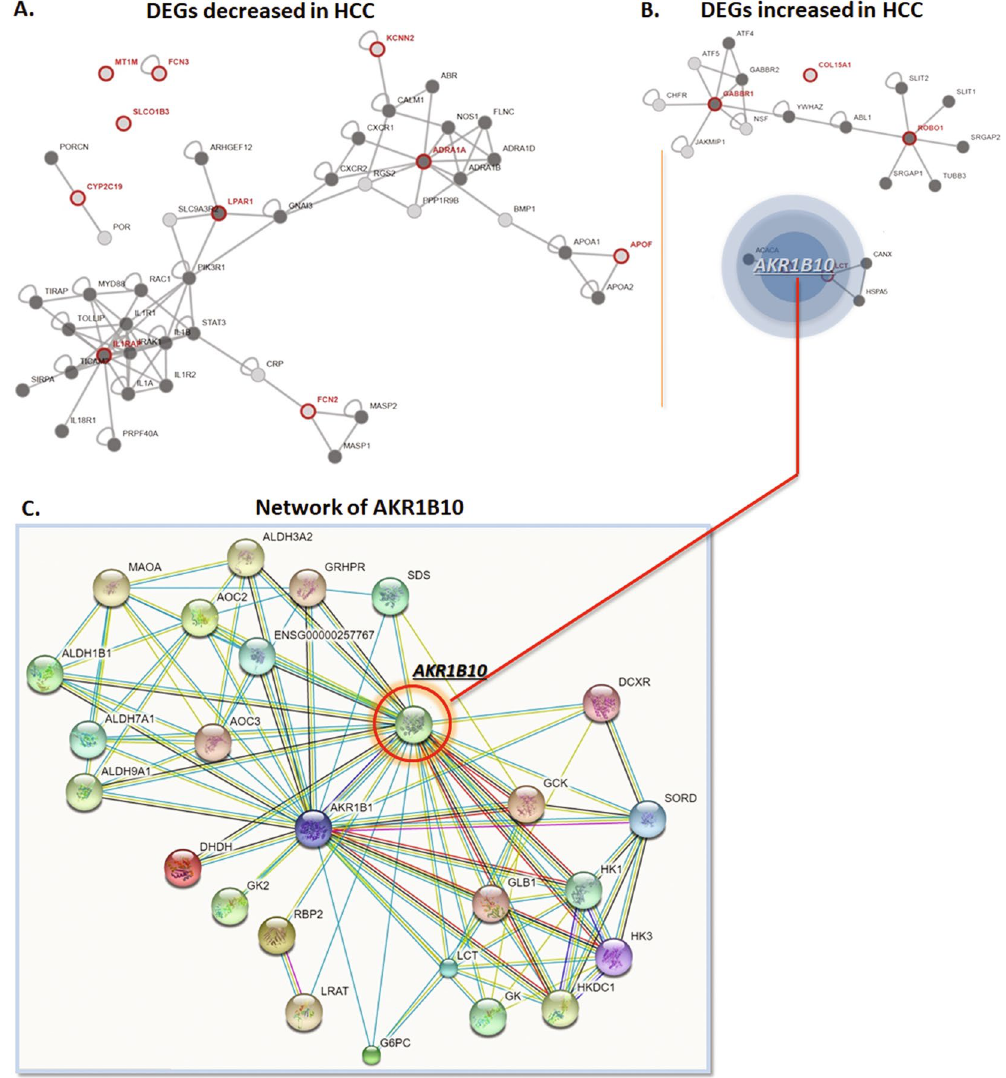
Figure 2. Protein-protein Interaction of the DEGs and selection of AKR1B10. ( A ) Online tool of STRING database analysis of the PPI network for the 11 DEGs decreased in liver cancer datasets. ( B ) Online tool of STRING database analysis of the PPI network for the 4 DEGs over-expressed in liver cancer datasets. ( C ) Amplification of the network for PPI associated with AKR1B10, which demonstrates a complex network between AKR1B10 and proteins critically functions in tumorigenesis and